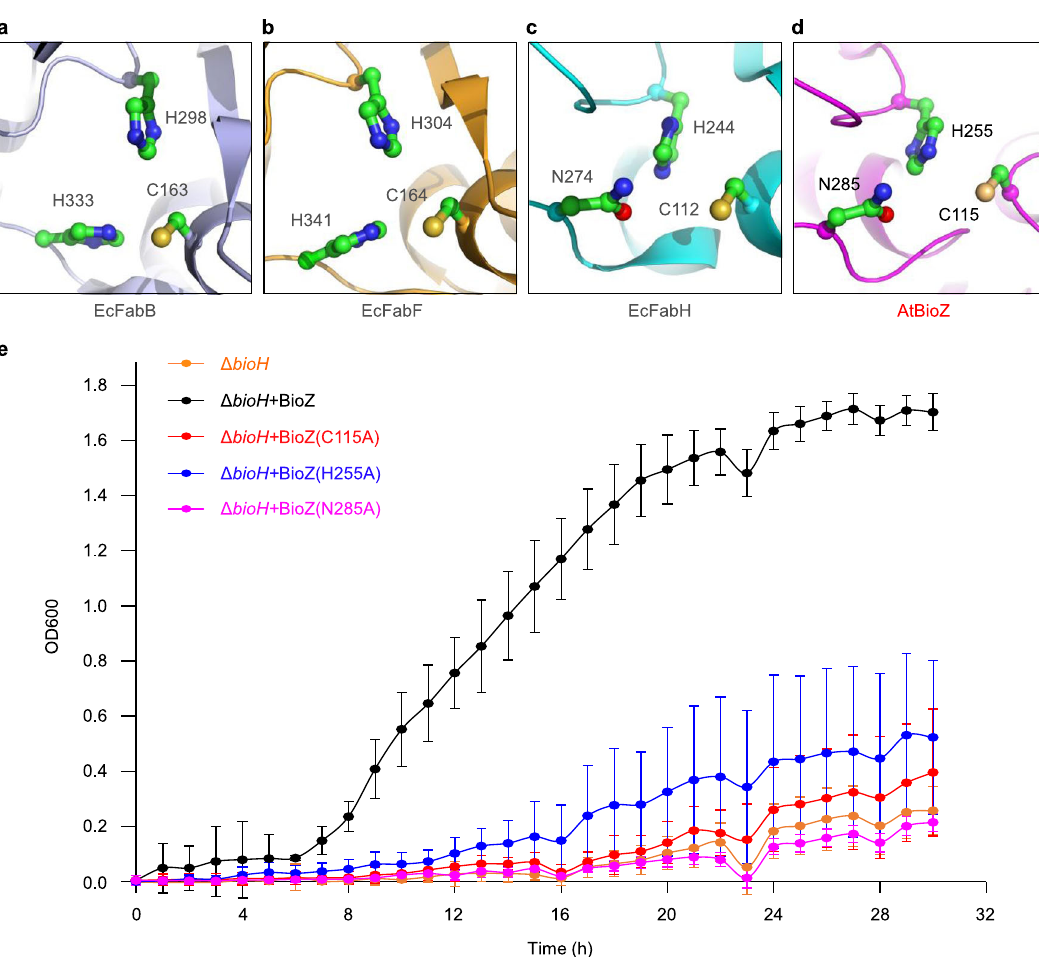
Fig. 5 Structural and functional analyses of the BioZ catalytic triad. a Structural snapshot of the catalytic triad (C163, H298, and H333) of EcFabB. b Structural analysis of the catalytic triad (C164, H304, and H341) of EcFabF. c Structural presentation of the catalytic triad (C112, H244, and N274) of EcFabH. d Structural illustration of the catalytic triad (C115, H255, and N285) of AtBioZ. The fi gures of structures were generated using the PyMol software. e Functional assays of BioZ and its catalytic triad mutants using the Δ bioH biotin-auxotrophic strain. The tested strains were grown on nonpermissive M9 minimal media lacking biotin. Growth curves were generated from three independent experiments and displayed in an average ± standard deviation